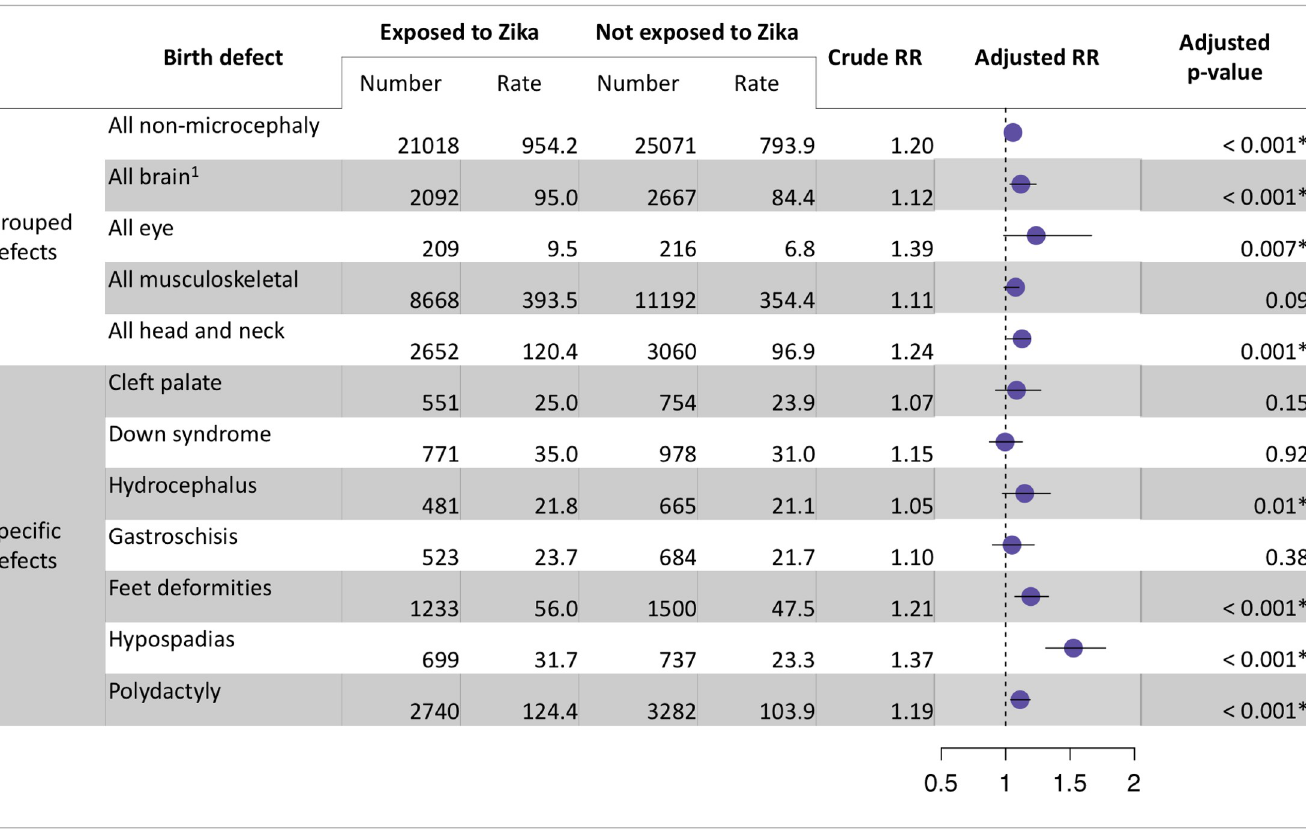
Fig 5. Relative risks of selected non-microcephaly birth defects with Zika virus. Exposure areas were defined as municipalities that experienced at least 1 case of Zika. Adjusted relative risk (RR) predictions show predictions for the median Zika incidence observed in Brazilian municipalities over the time period. Mean and 95% confidence intervals of relative risk are shown. The chi-squared test statistic was used with Bonferroni correction of p -values for 12 hypothesis tests. Significant results at the p = 0.05 level are denoted by an asterisk ( � ). Full ICD-10 categories for grouped defects are provided in S2 Text, section 2.6. 1 All brain defects category excludes